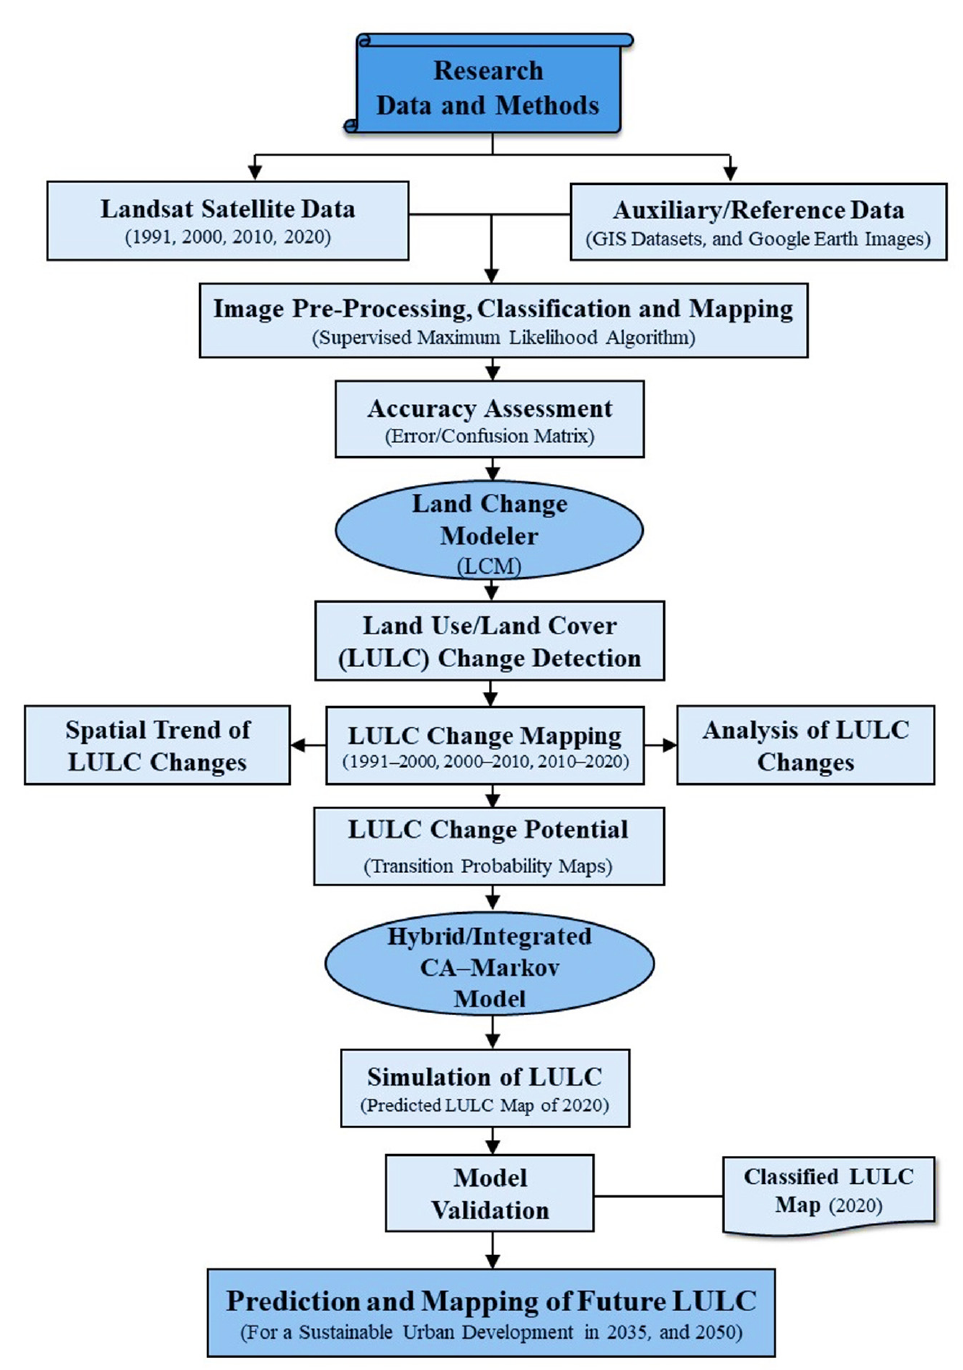
Figure 2. Methodological flow of predicting the study area’s future LULC.